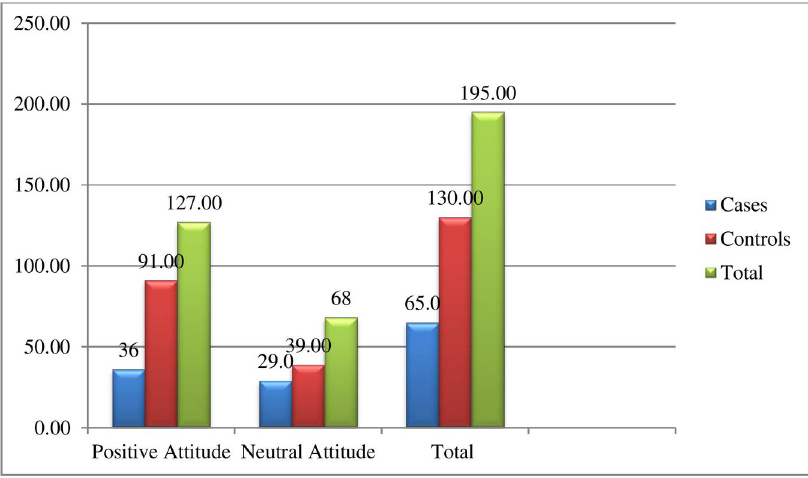
Fig 2. Attitude of cervical cancer screening among women in the age group of 30–49 years in Ambo town, Oromia Regional State, Ethiopia, February to March,